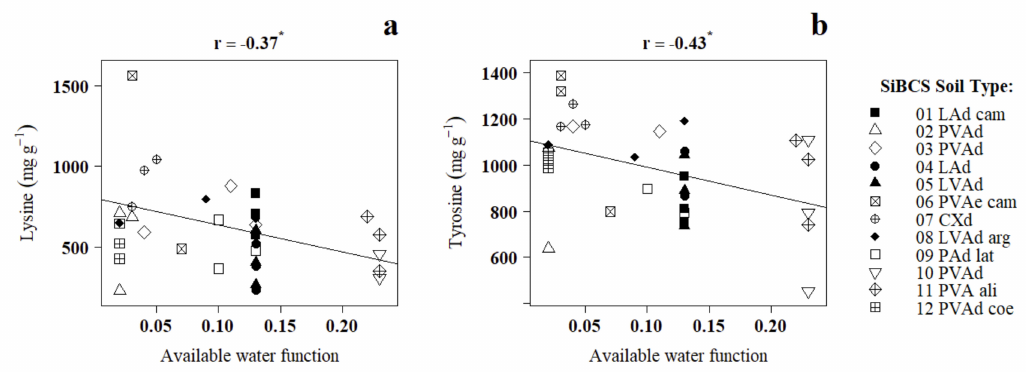
Figure 2. Pearson’s linear correlations (r) between the free amino acids lysine and glutamine, in PH-16 dry cacao beans, and the functions of the Soil Quality Index available water ( a ) and environmental safety ( b ) calculated for 12 crop sites in the southeast of Bahia. Significant at 5% error